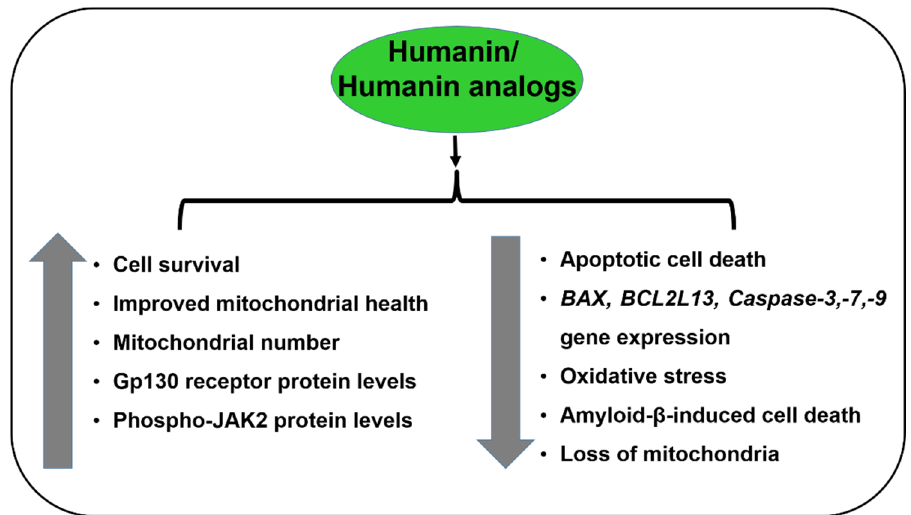
Figure 2. Effects of Humanin/Humanin analogs in RPE/ AMD. Figure 2. E ff ects of Humanin / Humanin analogs in RPE /